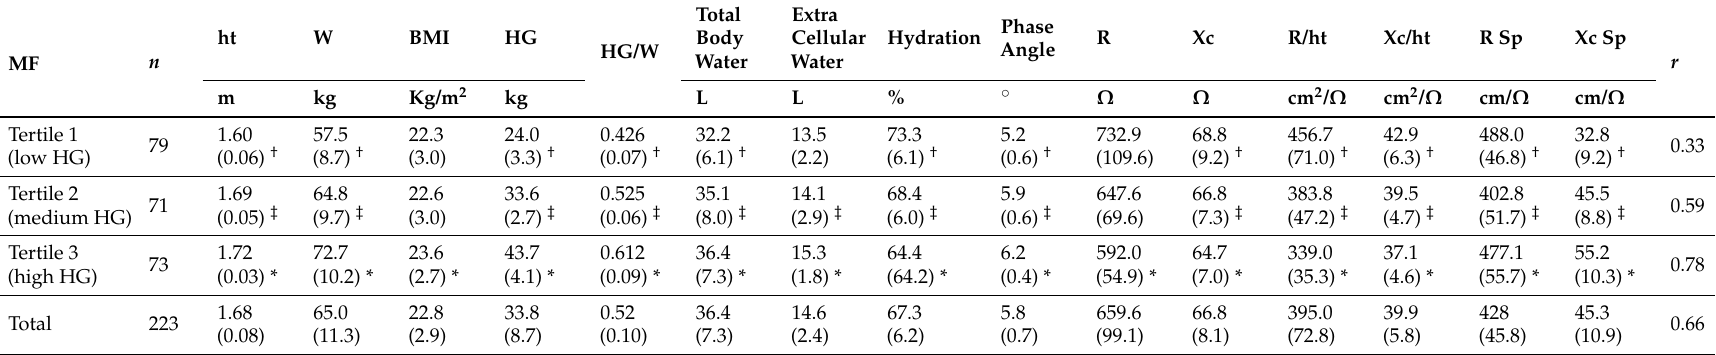
Data given as mean (standard deviation). W: Weight; BMI: body mass index; HG: handgrip; HG/W: handgrip (kg)/Weight (kg); R: resistance; Xc: reactance; Sp: specific; ht: height; r : correlation coefficient between R/ht and Xc/h; R/ht resistance standardized for h; Xc/ht resistance standardized for ht. ANOVA showed significant difference between T1 vs. T2 †